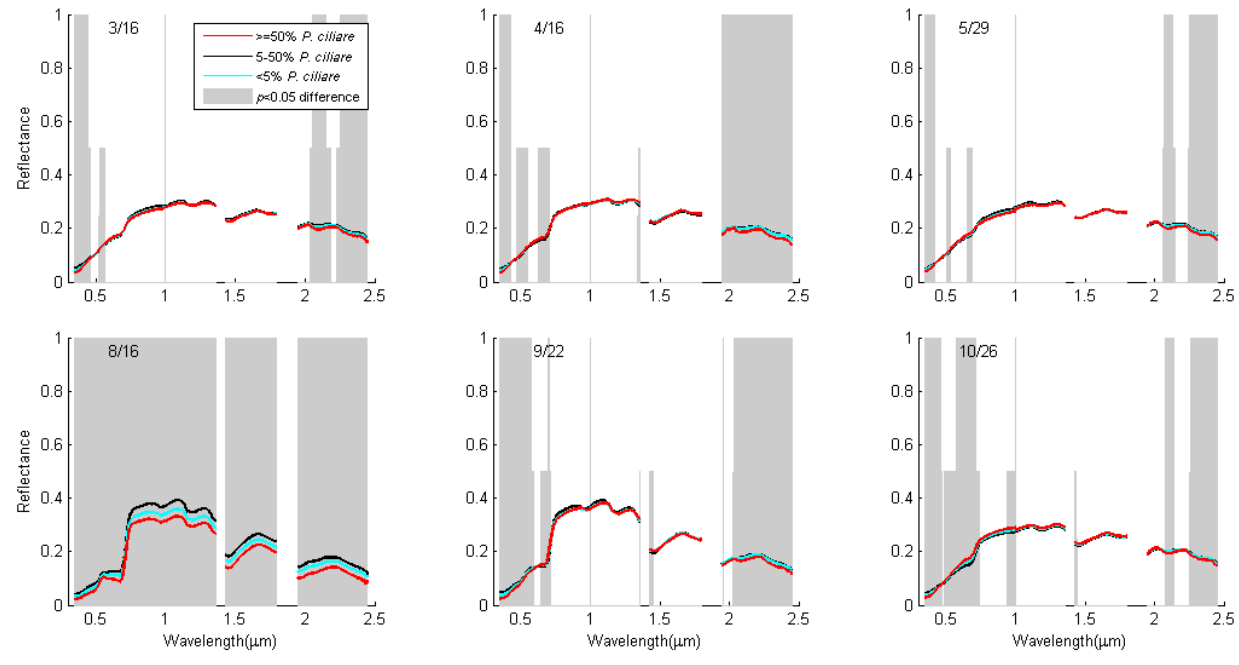
Figure 7. Mean simulated reflectance of densely infested ( ≥ 50% P. ciliare